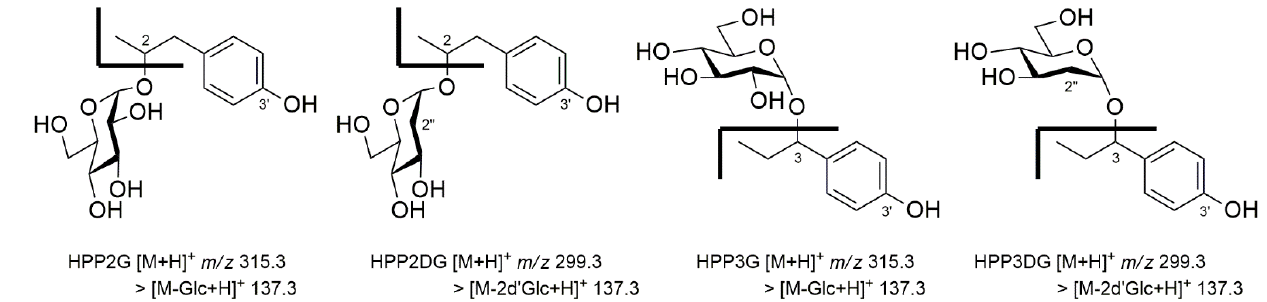
Figure 3. Chemical features of four SP glycosides obtained from StSPGT enzymatic reactions and their MS fragmentation patterns.